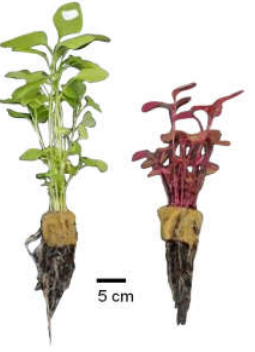
Figure 7. Red and green spinach at 15 days after planting. Table 1. Morphological and nutritional characteristics of green and red spinach.